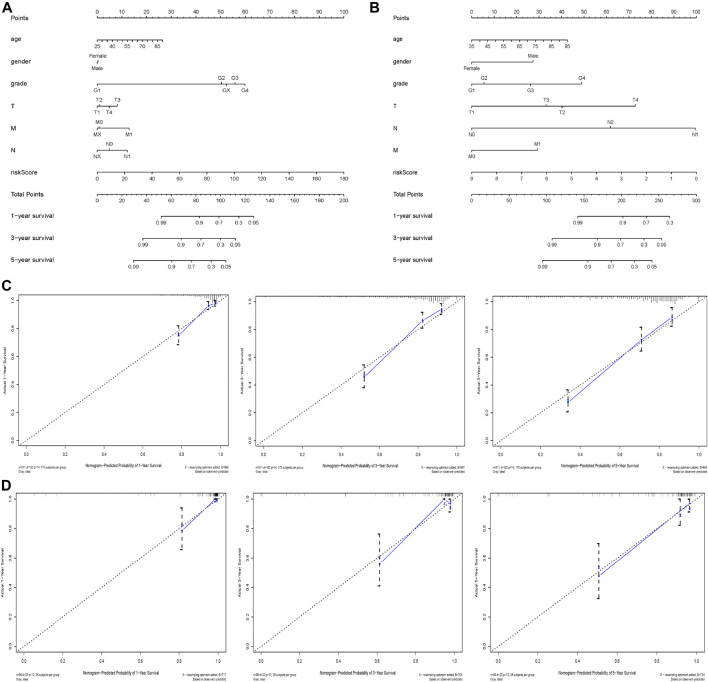
Nomogram and calibration plots based on our established signature and clinical characteristics in both TCGA and ArrayExpress databases; (A,B) Nomogram for predicting probabilities of patients with ccRCC with 1-, 3- and 5-year OS in the TCGA and ArrayExpress databases respectively; (C,D) The calibration plot of the nomogram for agreement test between 1-, 3- and 5-years OS prediction and real outcome in the TCGA and ArrayExpress databases separately.